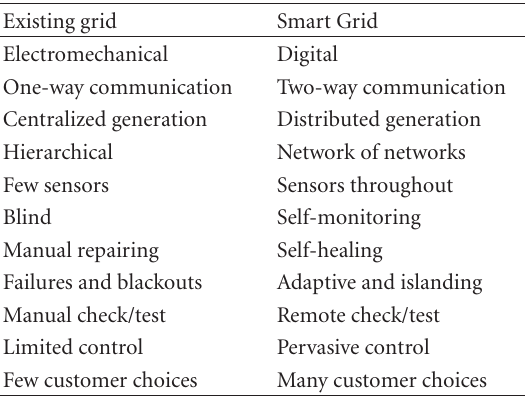
Table 1: Smart Grid innovations versus existing power